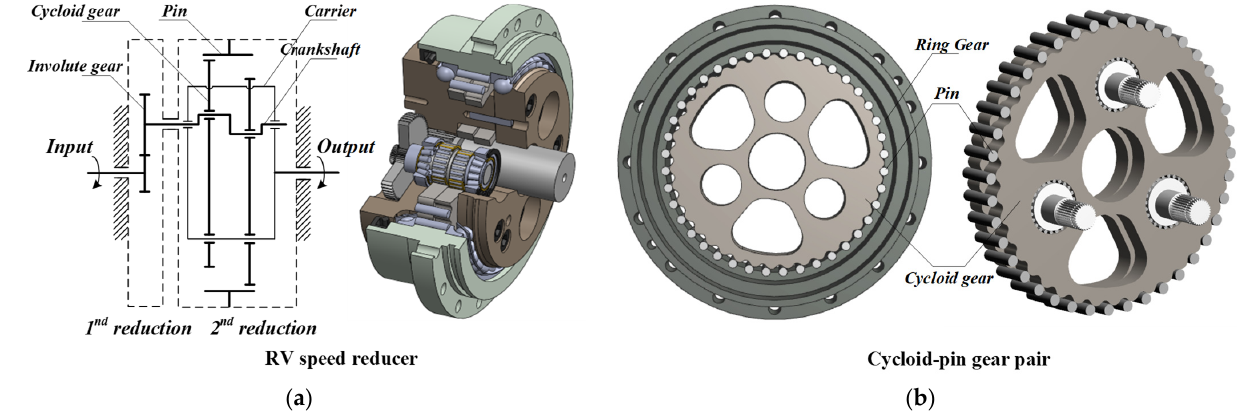
Figure 1. ( a ) The schematic view of an RV speed reducer; ( b ) the 3D model of a cycloid-pin gear